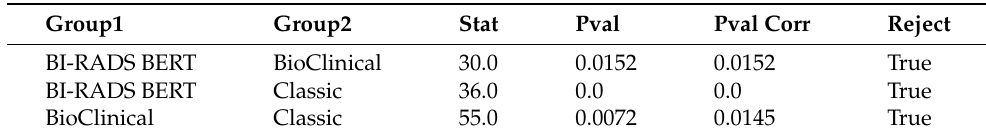
Table A10. Bonferonni-corrected McNemar test results for field extraction with no section segmenta- tion of modality.